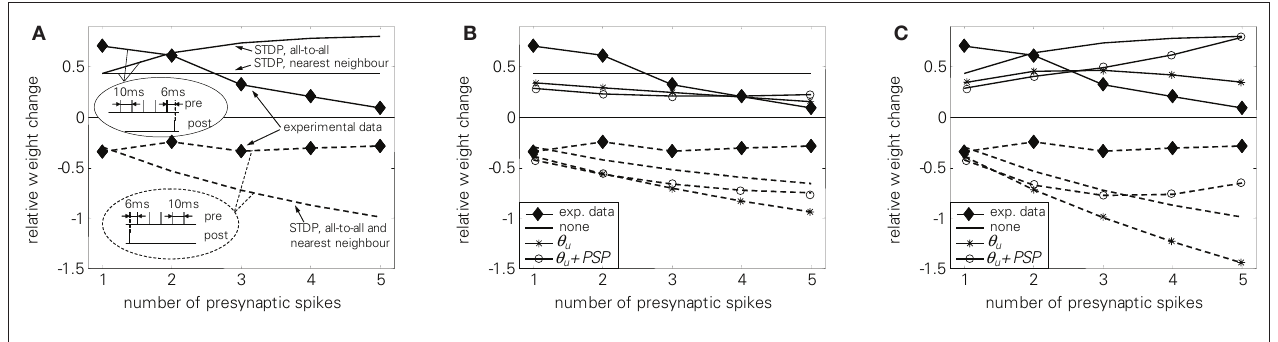
FigurE 14 | Presynaptic burst pairing protocol (5), full lines: pre-burst- post case, experiments and reproduction, dashed lines post-pre-burst case, experiments and reproduction. (A) standard STDP, (B) LCP with LIAF with nearest-neighbor interaction, (C) LCP with LIAF with all-to-all interaction. For the Θ curve in (B) and (C) , we set Θ u